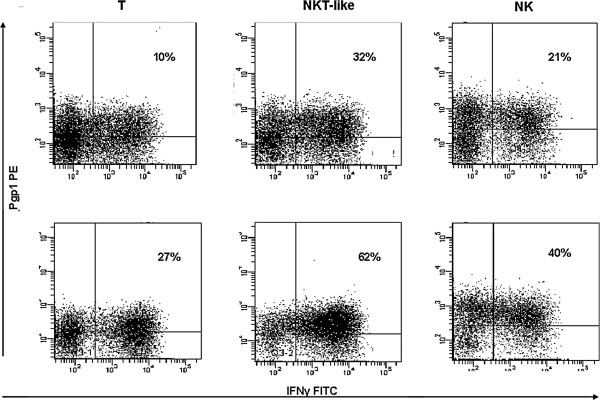
Representative dot plots showing increased IFNγ expression by Pgp1+ T, NKT-like and NK cells from a patient with COPD (bottom row) compared with a control subject (upper row).